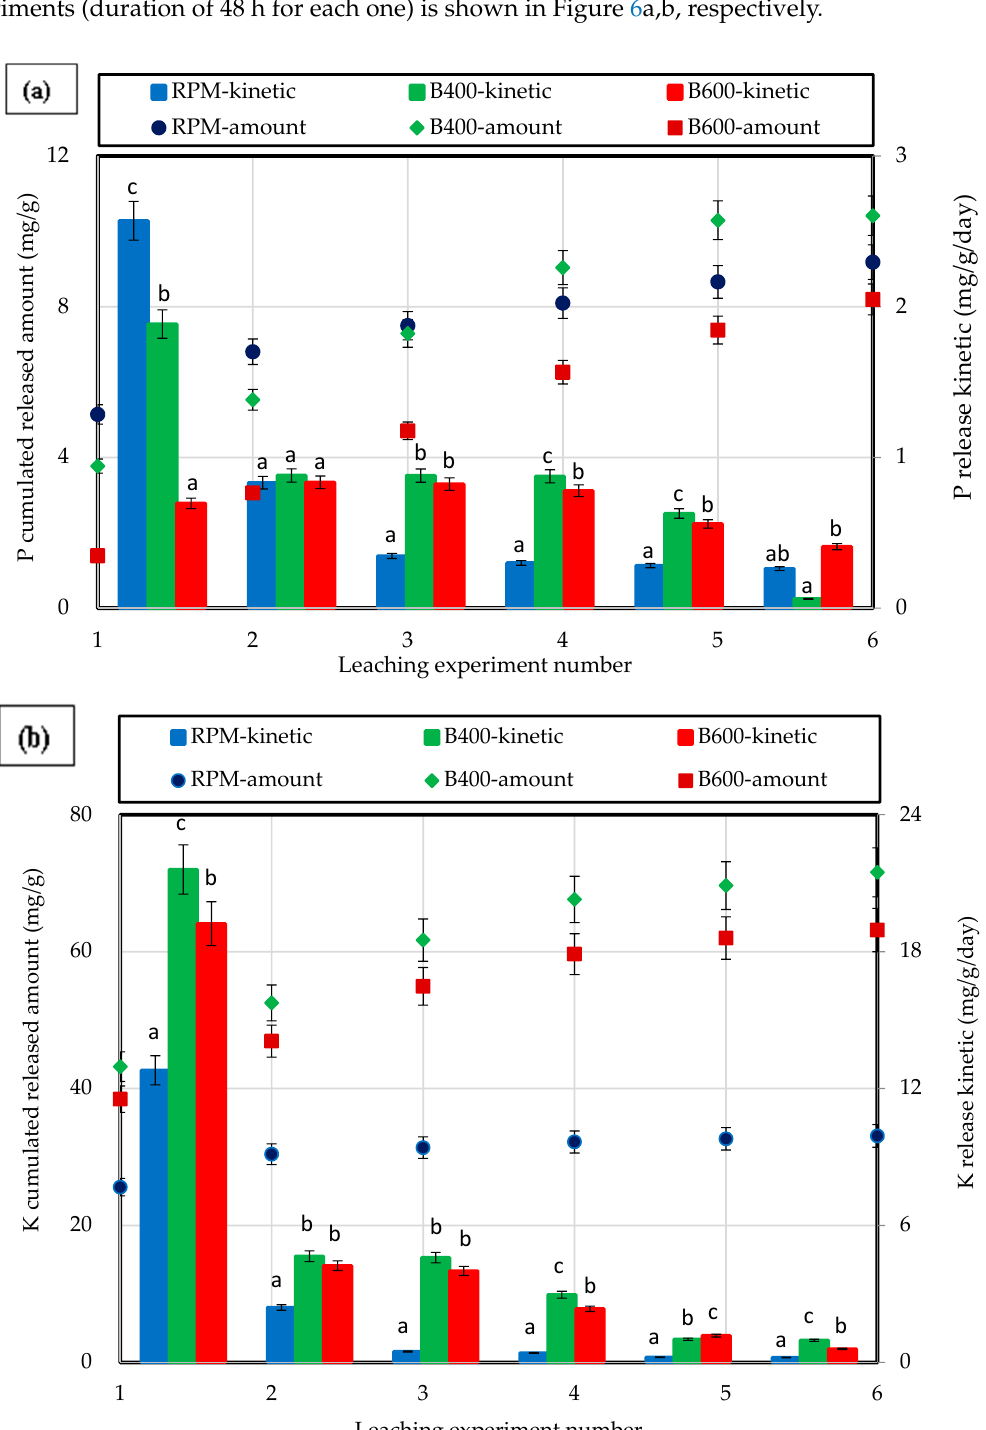
Figure 6. Effect of successive leaching experiments on the release of phosphorus ( a ) and potassium ( b ) from RPM and its two derived biochars: B400 and B600 (dosage = 10 g L-1; pH = 6.2; T = 20 ± 2 °C). At each leaching experiment number, means with the same lowercase letters are not statistically different at p < 0.05.